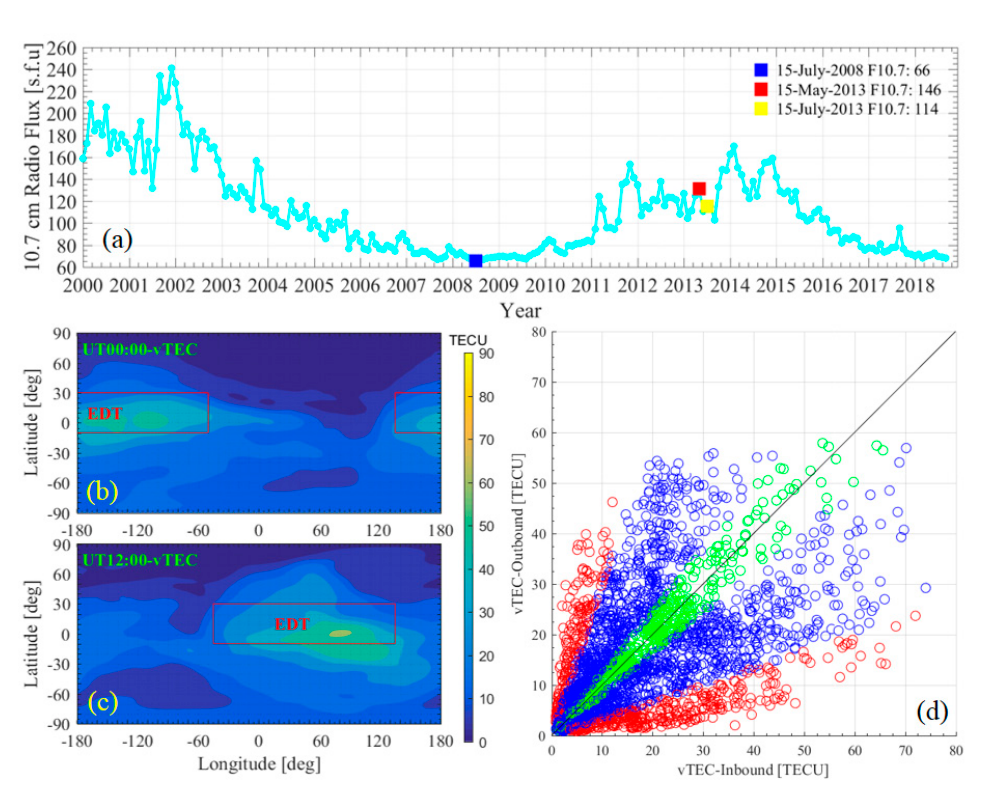
Figure 3. Time series of monthly mean F10.7 index for the years from 2000 to 2018 ( a ) illustrating the three test days with square marks. The International GNSS Service (IGS) vTEC maps of the 00:00 UT (universal time) and 12:00 UT on 15 July 2013 are shown in panels ( b , c ), respectively. In panels ( b , c ), the equatorial day time (EDT) zone is highlighted with a red box. ( d ) vTEC scatter plot illustrating inbound vTEC ( x -axis) vs. outbound vTEC ( y -axis), classifying the ionospheric conditions into nearly symmetric (green; inbound-vs-outbound vTEC variation against mean vTEC within +/ − 10%), moderately asymmetric (blue; vTEC variation in between green and red), and strongly asymmetric (red; inbound-vs-outbound vTEC variation against mean vTEC larger than +/ −